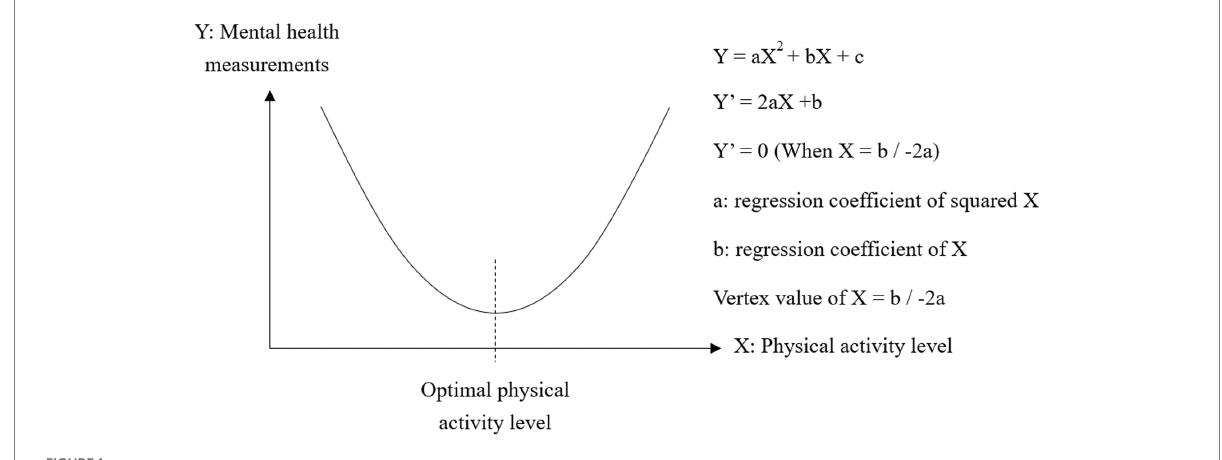
FIGURE 1 Explanation of quadratic equation model regression